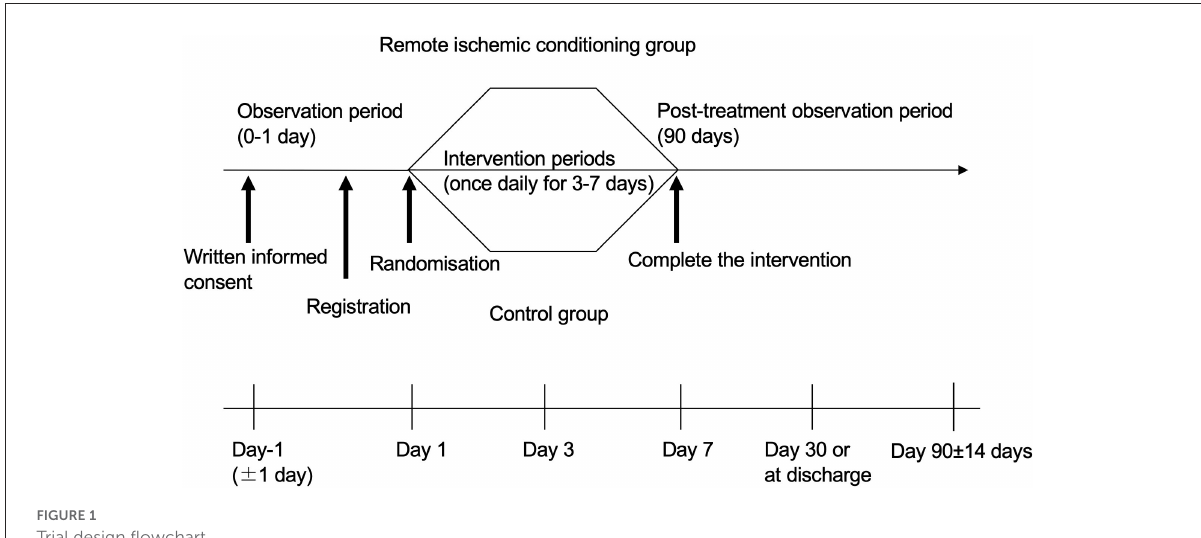
FIGURE1 Trial design